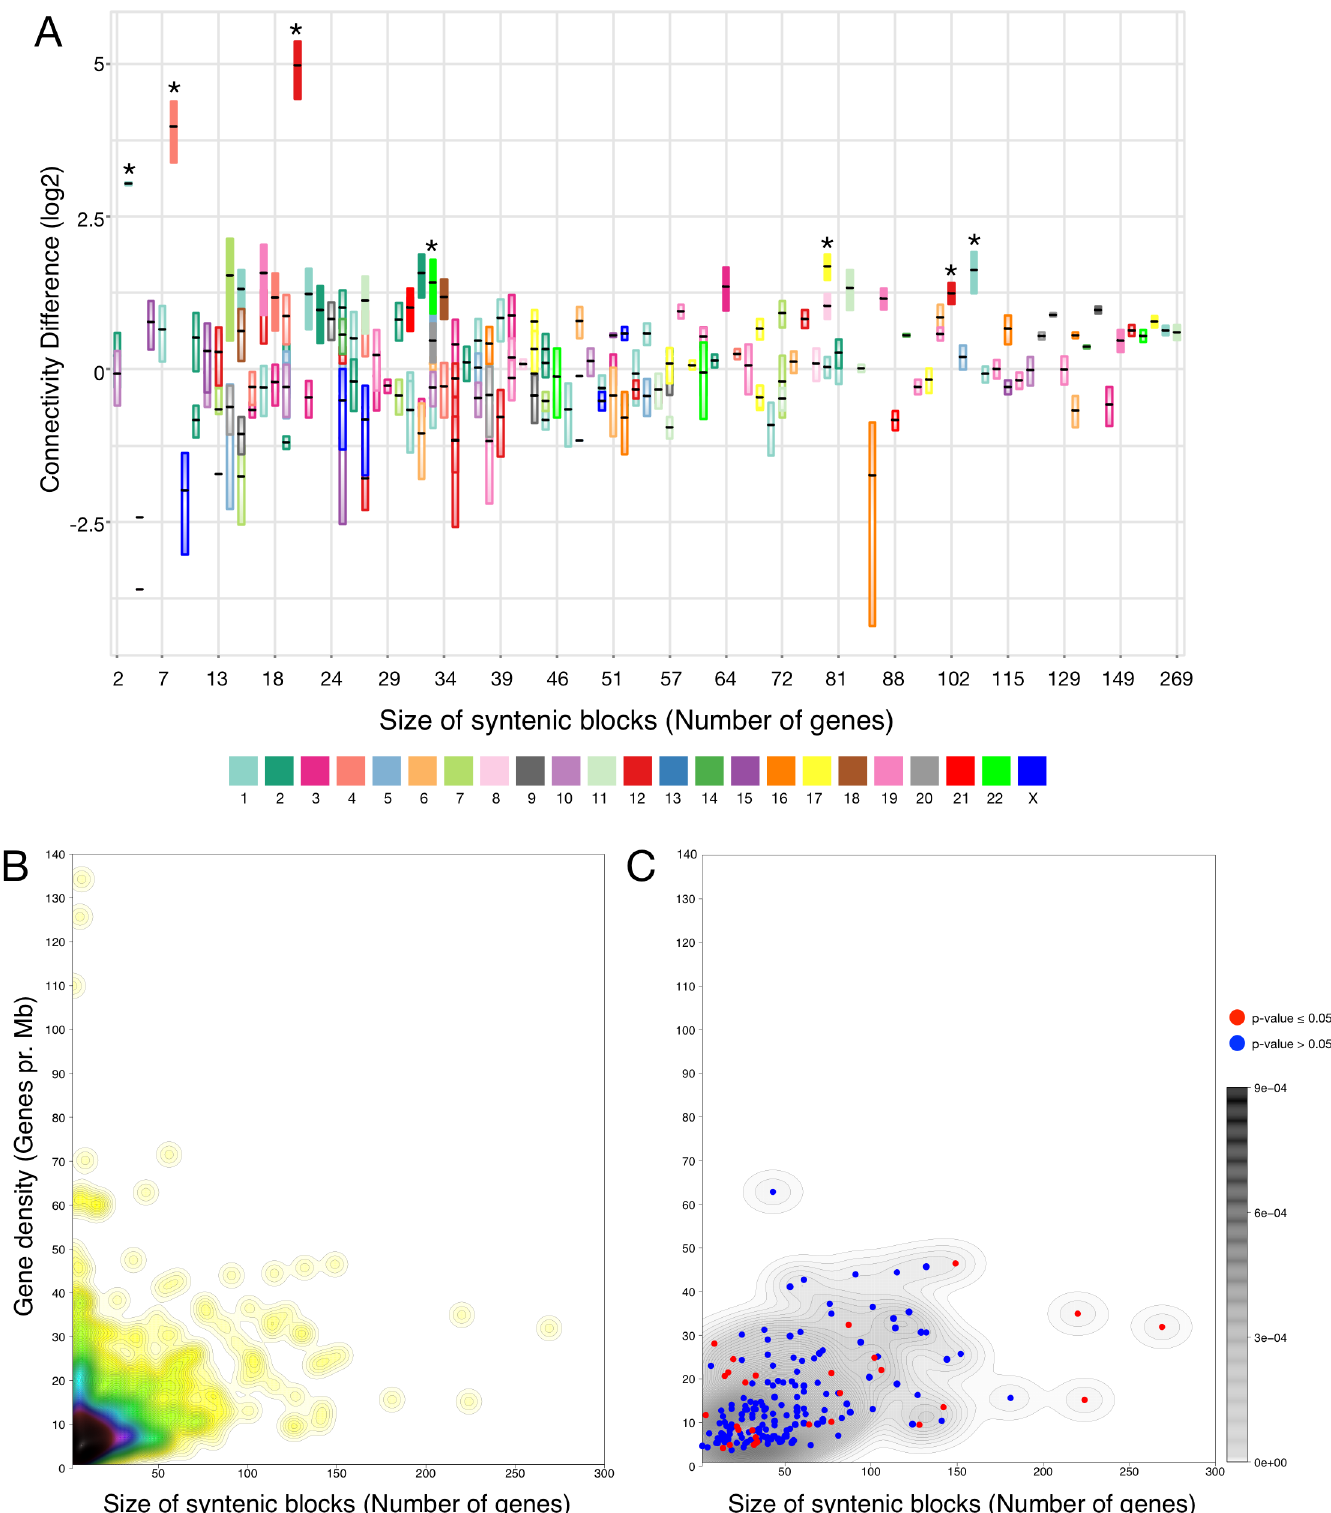
Fig 2. Connectivity and gene density of conserved syntenic blocks. (A) The connectivity ratio (CR) per block was calculatedas the number of observed cis-PPIs dividedby the numberof observed trans-PPIs, each normalizedby the theoretical numberof cis- and trans-PPIs. The plot shows the